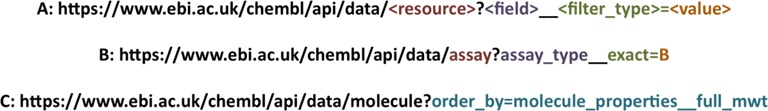
ChEMBL web service filtering and sorting examples. A: Example arguments for web service filter query (note the double underscore between <field> and <filter_type>). B: Example web service query returning binding (‘B’) assays. C: Example web service ordering query, which returns molecules ordered by molecular weight in ascending order. The ordering can be changed to descending order by placing a minus sign before the field name, e.g. ‘order_by = -molecule_properties__full_mwt’.